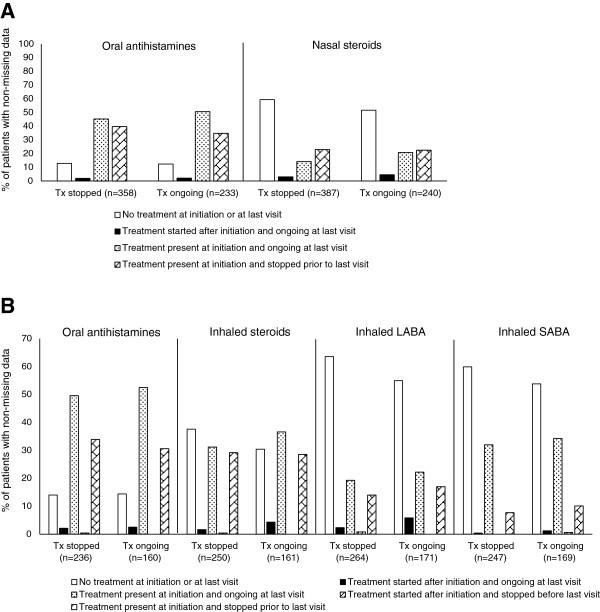
Change in symptomatic medication use during SLIT. A. Symptomatic treatments for allergic rhinitis / B. Symptomatic treatments for asthma.